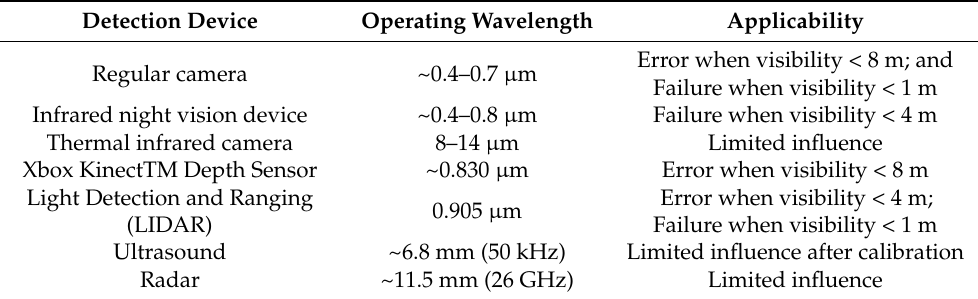
Table 1. Applicability of detection devices under fire smoke environment [9].